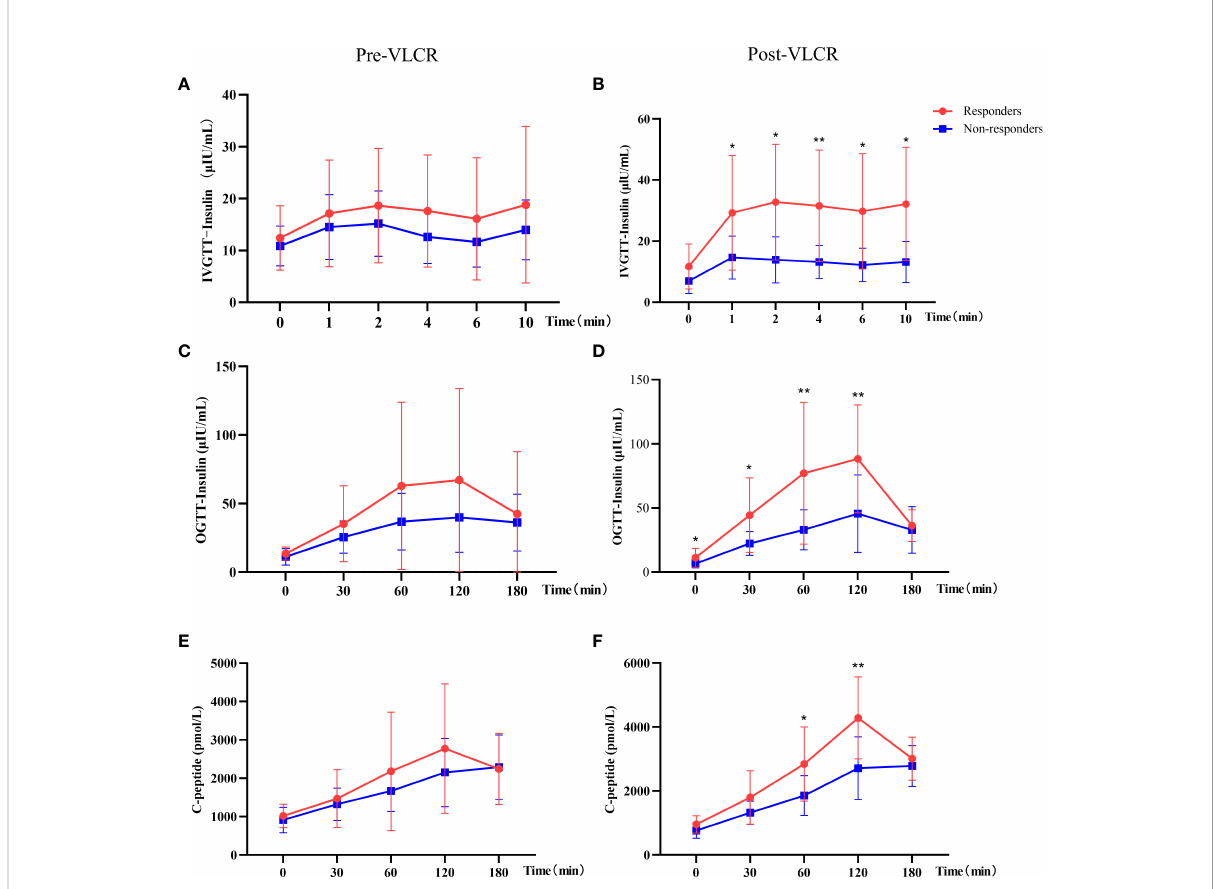
FIGURE 2 Comparison of insulin and C-peptide in IVGTT and OGTT before and after VLCR in responders and non-responders. (A, B) , insulin secretion in IVGTT pre- (left) and post-VLCR (right); (C, D) , insulin secretion in OGTT pre- (left) and post-VLCR (right); (E, F) , C-peptide secretion in OGTT pre- (left) and post-VLCR (right). * P <0.05, ** P <0.01, responders vs. non-responders at different time